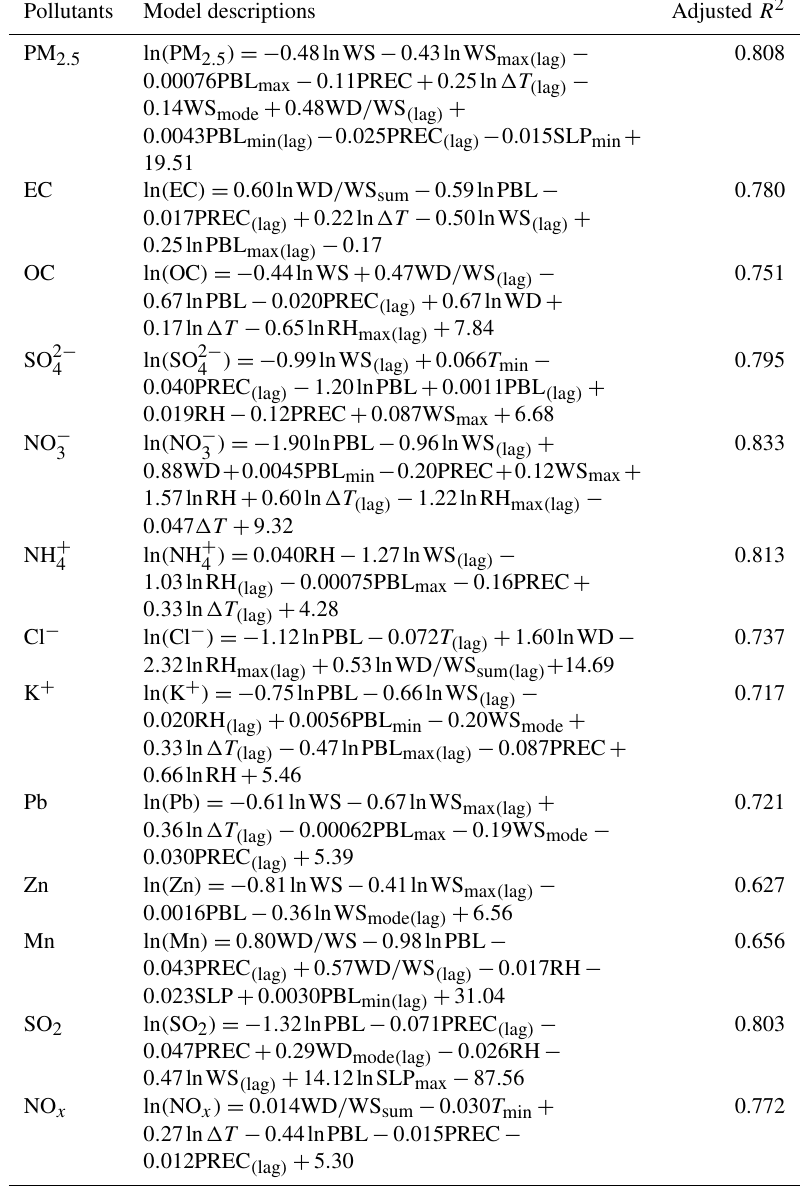
Table 6. The concentrations of air pollutants for the GLM with adjusted R 2 values higher than